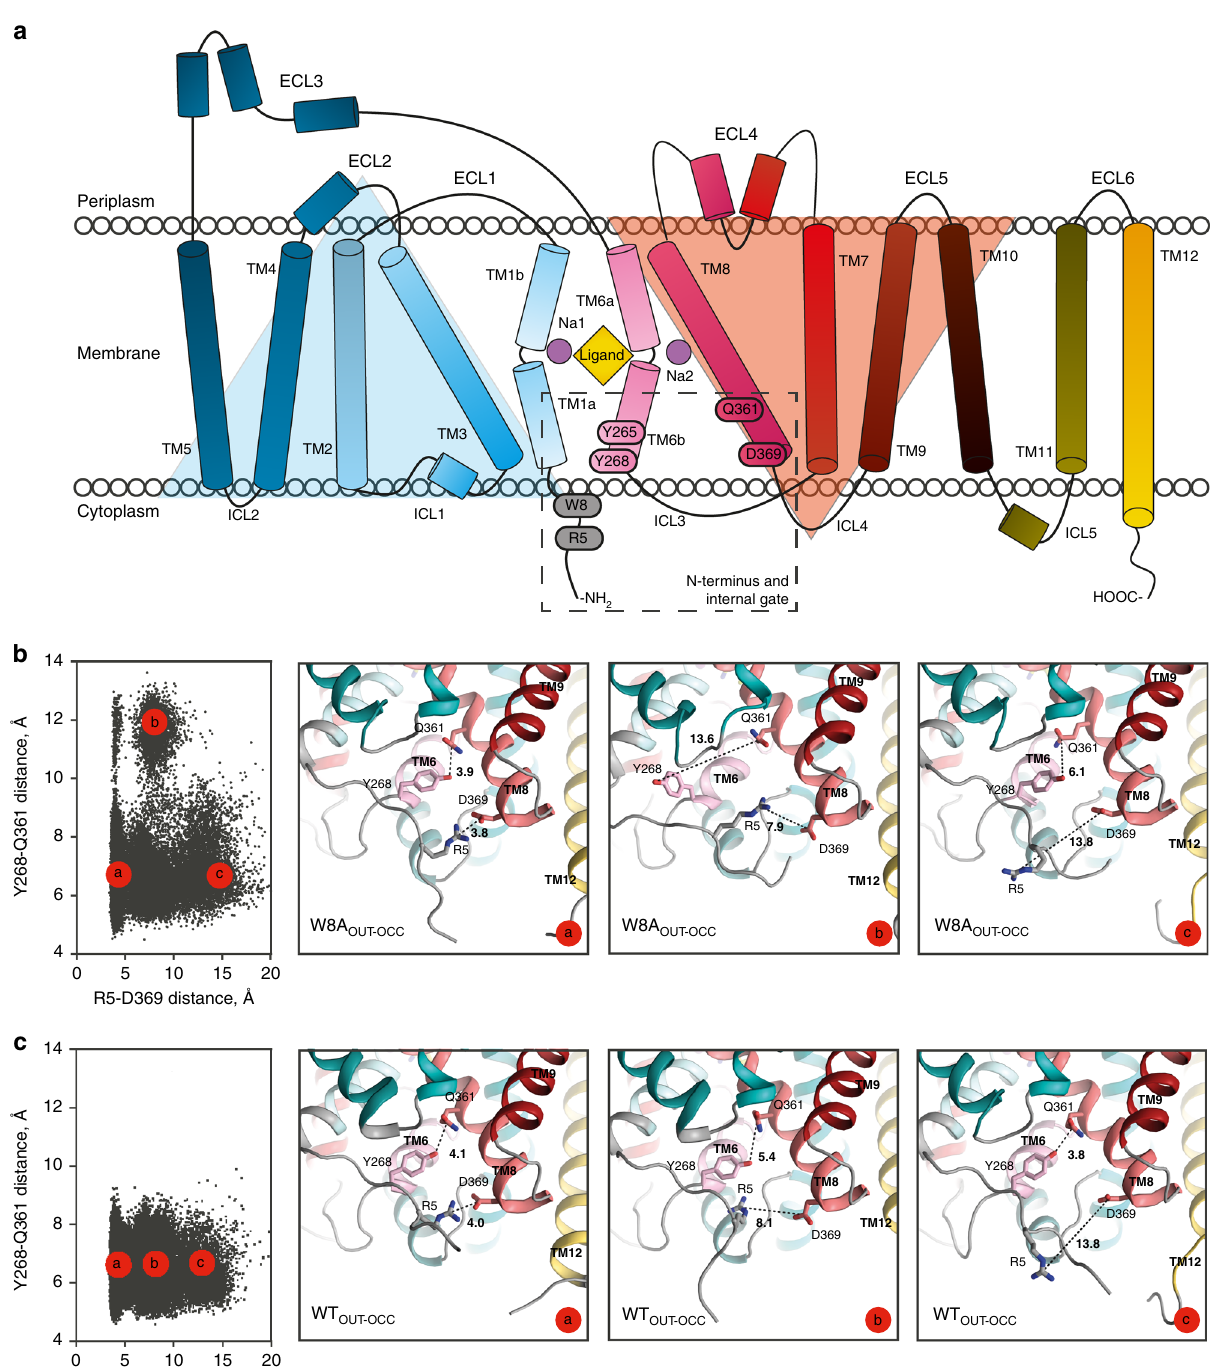
Fig. 2 Secondary structure of LeuT and conformational dynamics of the intracellular gate. a Topology of the LeuT monomer with transmembrane segments (TMs) 1-12, extracellular loops (ECLs) 1 – 6 and intracellular loops (ICLs) 1 – 5. TMs 1 – 5 and TMs 6 – 10 are related by a pseudo two-fold rotation as highlighted by the light blue and orange triangles, respectively 10 . Dashed rectangular indicates region, including the N-terminal W8 residue and residues constituting the internal gate (R5, Y265, Y268, Q361, and D369). b Conformations of W8A OUT-OCC LeuT construct collected from the ~10- µ s ensemble MD trajectories (run in 10 statistically independent replicates, each ~1- µ s long) projected onto two-dimensional (2D) space of the R5-D369 and Y268-Q361 distances. Each black dot (left panel) represents one snapshot from the combined trajectories of the 10 replicas, collected at 800-ps intervals for a total of >10.000 points. The three right panels are structural representations of the system corresponding to the three microstates ( “ a ”–“ c ” ), highlighting various degrees of opening of the two gates. The structures show the protein (close-up of the gate residues R5, D369, Y268, and Q361) with the above-mentioned distances indicated. c Conformational dynamics of the intracellular gate of WT OUT-OCC LeuT construct. Both the 2D and corresponding structural representations are shown similarly to Fig.